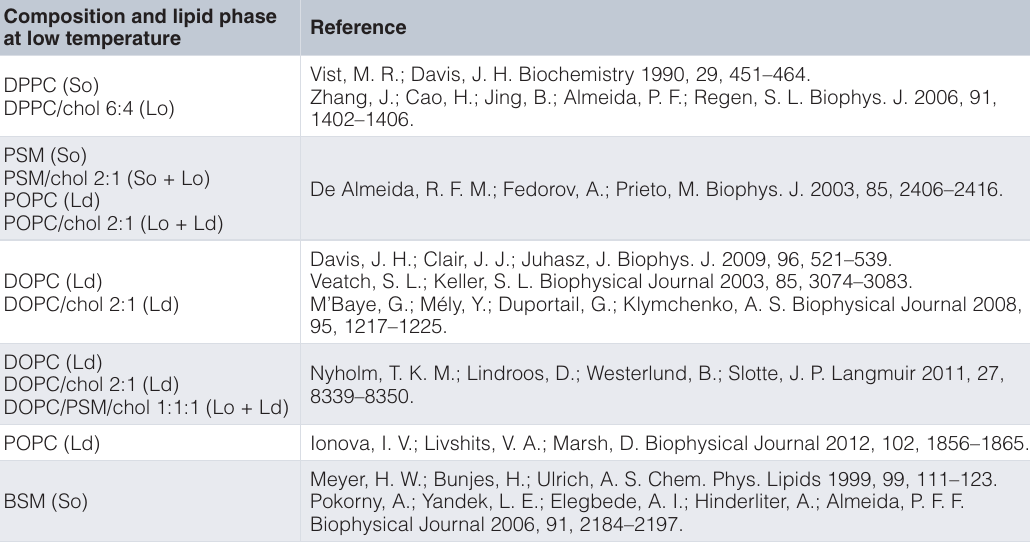
Supplemental Table S1. Bibliographic references for the composition of the bilayers used to obtain de various lipid phases. Composition and lipid phase at low